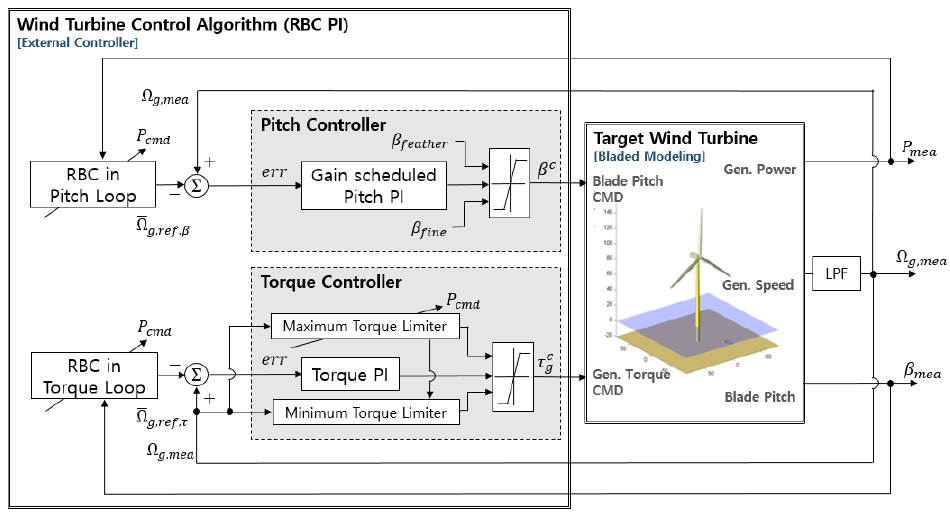
Figure 4. Block diagram of RBC PI control algorithm.